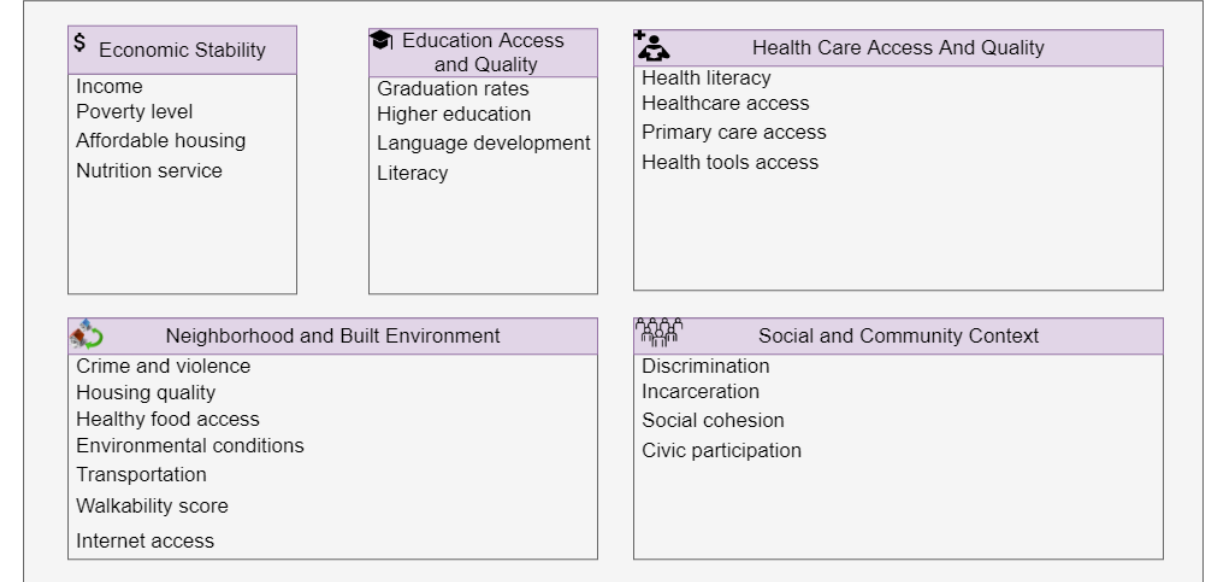
Figure 1. Five domains and variables of the Social Determinants of